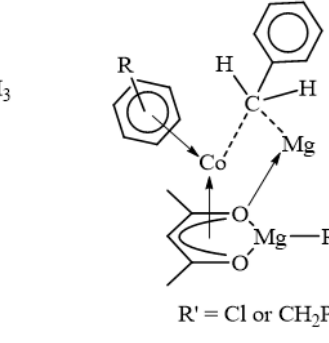
Figure 11. Real (red line) and simulated (blue line) EPR spectra of the catalytic system formed in toluene and in an argon atmosphere on the base of Co(acac) 2 and ( a ) Li- n -Bu or ( b ) PhCH 2 )MgCl, recorded at T = 77 K.